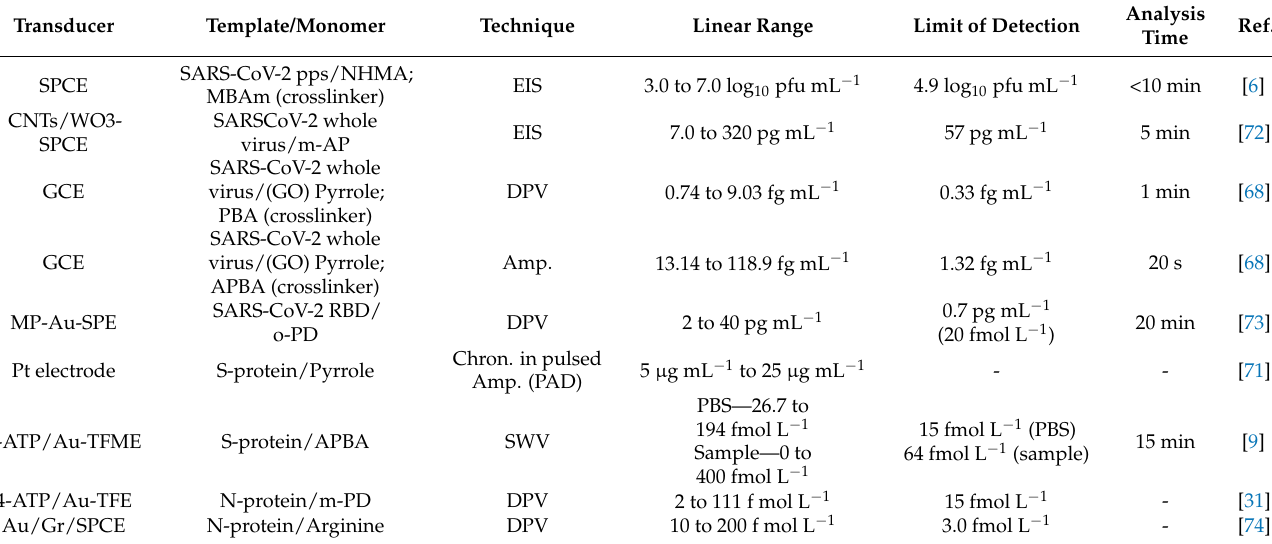
Table 5. Summary of MIP-based biomimetic sensors for SARS-CoV-2